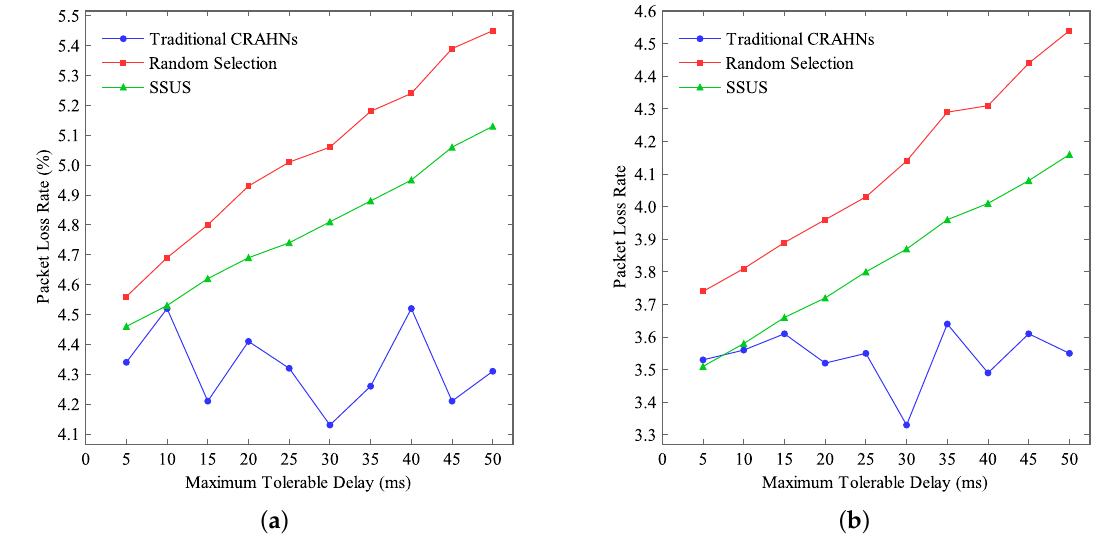
Figure 8. Packet loss rate vs. t δ . ( a ) Network size is 100 × 100 m 2 ,( b ) Network size is 60 × 60 m 2